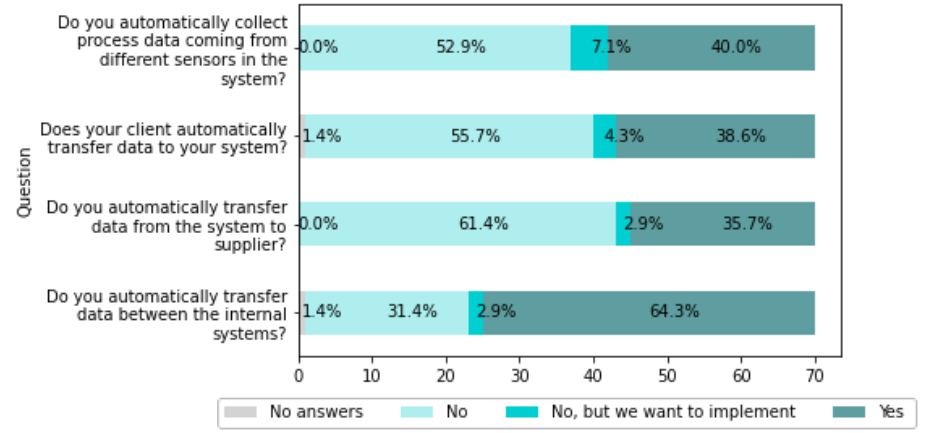
Figure 14. The functionalities of the systems related to the data transfer automatization implemented in the companies—number of questionnaires and percentage of answers in the total number of 70 questionnaires.